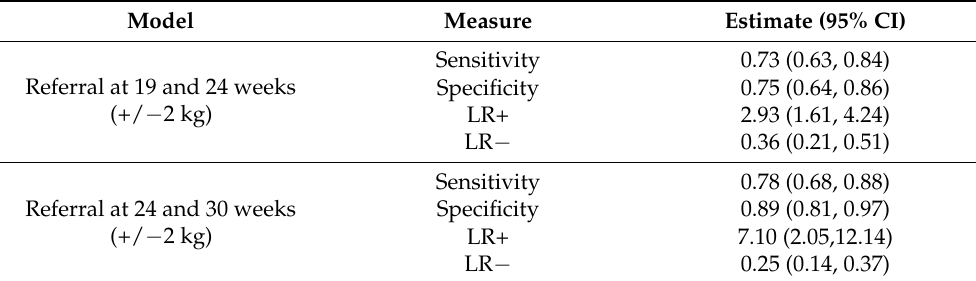
Table 4. Sensitivity, specificity, and positive and negative likelihood ratios for referral at two consecu- tive time points (+/ − 2 kg only) predicting GWG above or below (+/ − 2 kg) the recommended range at 36 weeks’